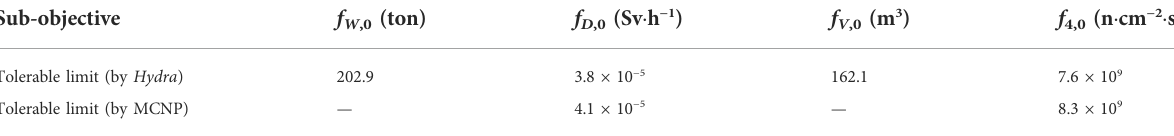
TABLE 2 Tolerable limits of the sub-objectives.